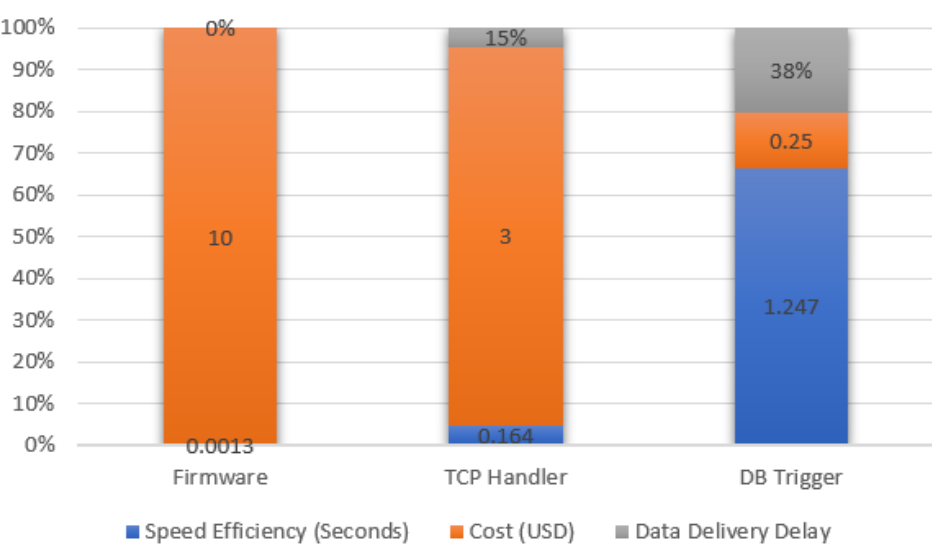
Figure 5. Proposed solutions comparison in term of speed, cost and data delivery delay.